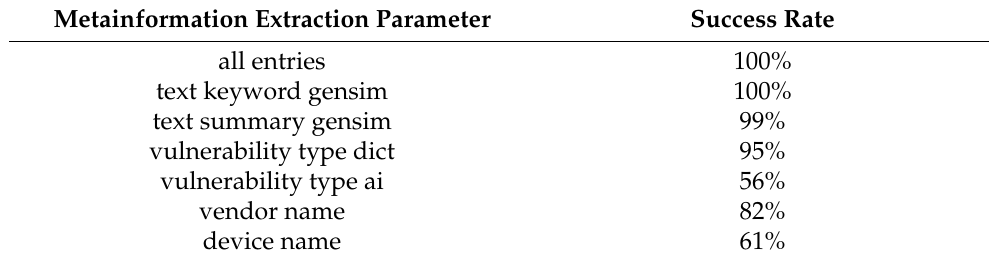
Table 6. Metainformation extraction